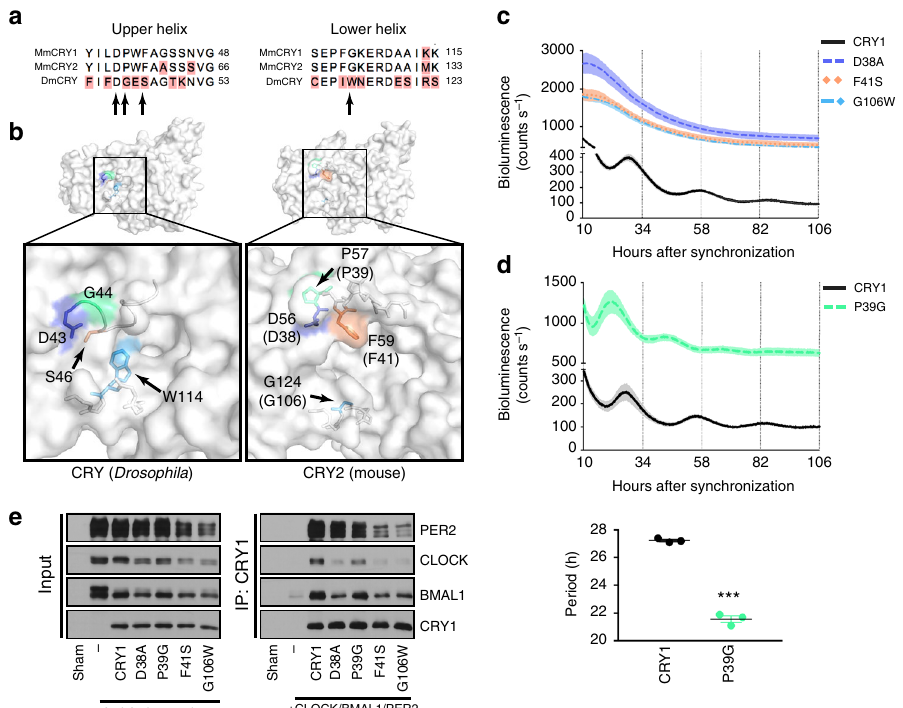
Fig. 4 Structural differences at the secondary pocket differentiate type I and type II CRYs functionally. a Alignment of the amino acids in the upper and lower helical boundaries of the secondary pocket of CRYs from Mus musculus (Mm) and Drosophila melanogaster (Dm). Residues examined in Fig. 4 indicated by arrows. Red shading indicates disagreement with consensus. b Surface view of the secondary pocket of dCRY (PDB: 4GU5) and CRY2 (PDB: 4I6E). Orthologous residues in dCRY and mCRY2 identi fi ed in the SCA and examined in greater detail here are colored here in correspondence with the rest of the fi gure. CRY1 residues are shown in parentheses. c Rescue assays for mutants of three residues in CRY1 identi fi ed in the SCA ( n = 3 per condition, re fl ective of 9 (D38A), 12 (F41S), and 9 (G106W) plates from 3 – 4 independent experiments) shown as mean ± SEM. d Rescue assay for CRY1 P39G ( n = 3, re fl ective of 6 total plates from two independent experiments) shown as mean ± SEM. Period plot for rescues in d shown in the plot below. Mean± SEM indicated by bars. Asterisks show signi fi cance by unpaired t test with Welch ’ s correction (*** p = 0.0006). e Co-IP assay with PER2, CLOCK, BMAL1, and various CRY1 mutants. Blot is representative of at least three independent